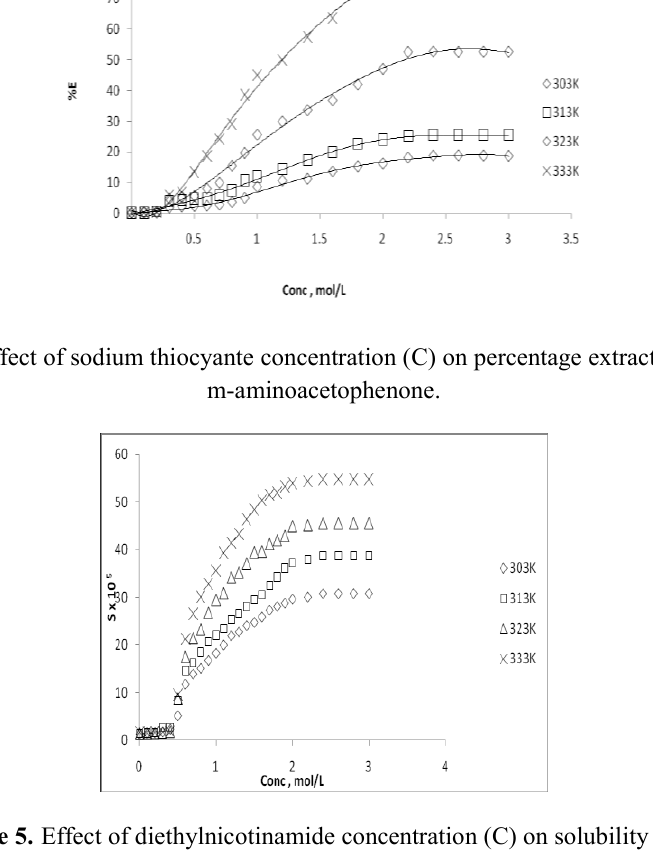
Figure 5. Effect of diethylnicotinamide concentration (C) on solubility of m-